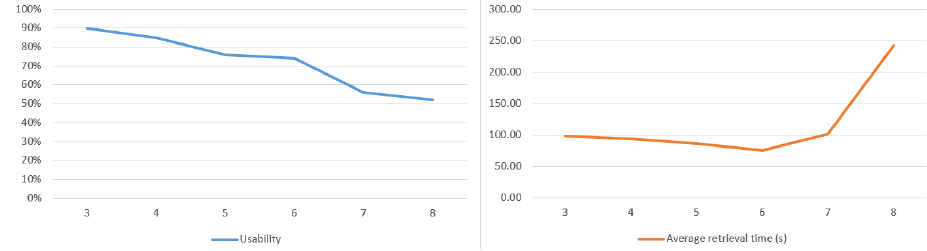
Figure 8. Optimal number of available